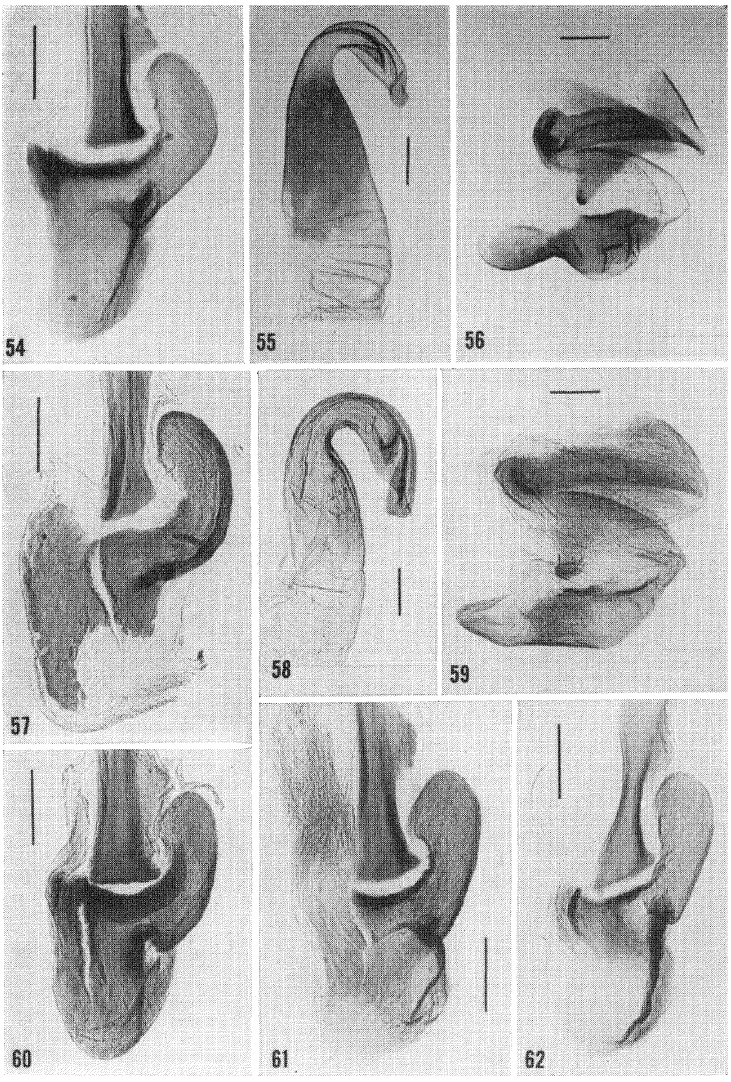
Figs. 54-62. Lanxoblatta emarTinata. 54-56. (2 ANSP). (from adult shown in Fig. 8). 57-59. (9 MCZ). Ecuador. 60. (10 MCZ). Probably Brazil. 61. (6 ANSP). St. John du Maroni, French Guiana. 62. (7 ANSP). Antioquia, Colombia. (scale 0.2